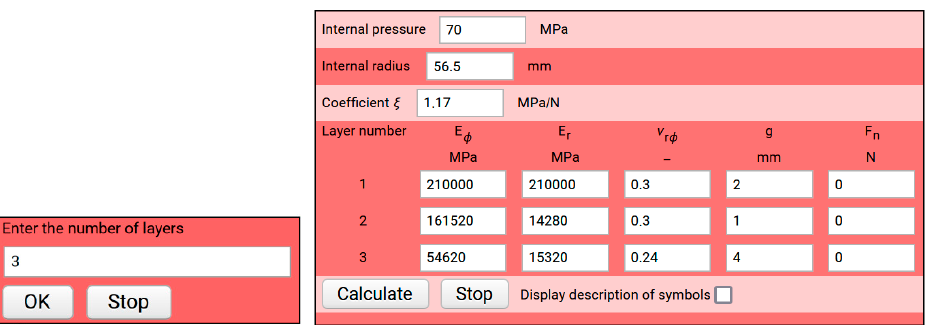
Figure 25. Dialogue window of the structure data.